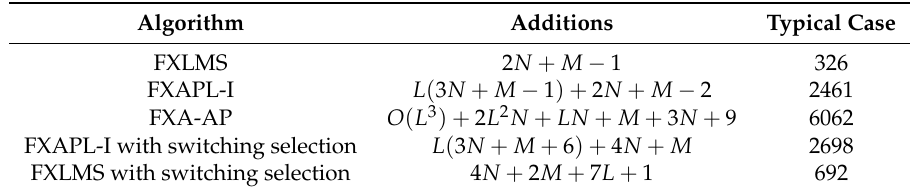
Table 2. Number of additions per iteration of the FXLMS, FXAPL-I, FXA-AP, FXAPL-I with switching selection and FXLMS with switching selection algorithms for a single-channel ANC system. Typical case: M = 128, N = 100 and L = 5.